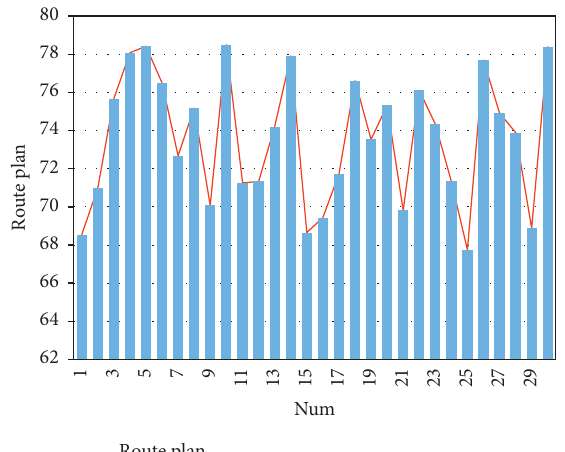
Figure 9: Statistical chart of the route planning efect of the robot based on deep learning.